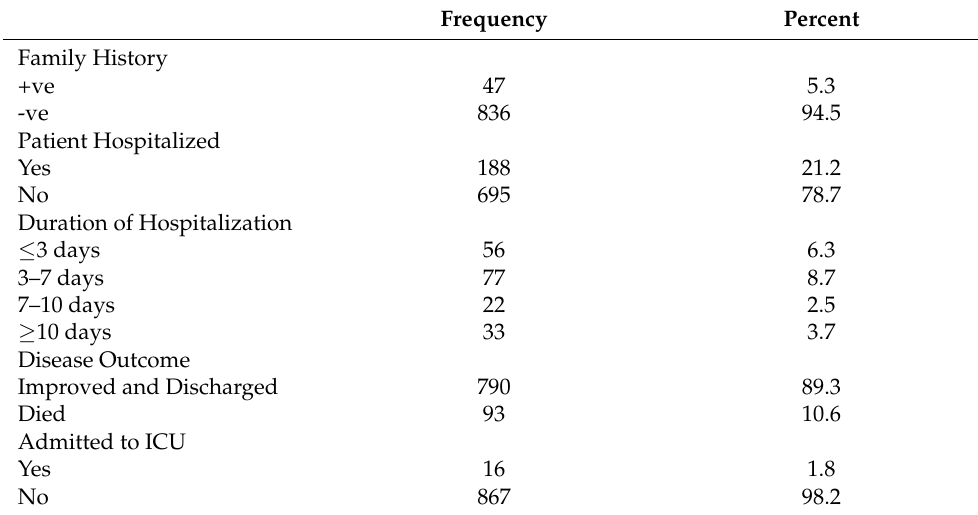
Table 2. Clinical history of VTE